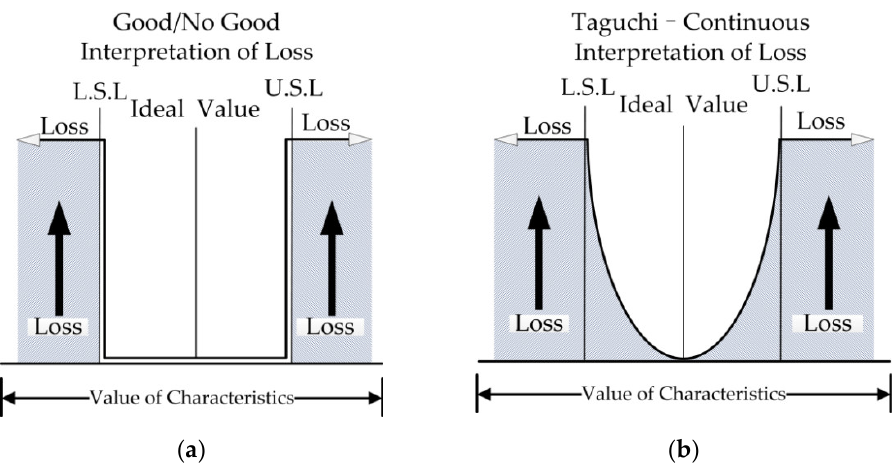
Figure 2. Two views of quality loss: ( a ) Traditional view of quality loss; ( b ) Taguchi’s quality loss approach.